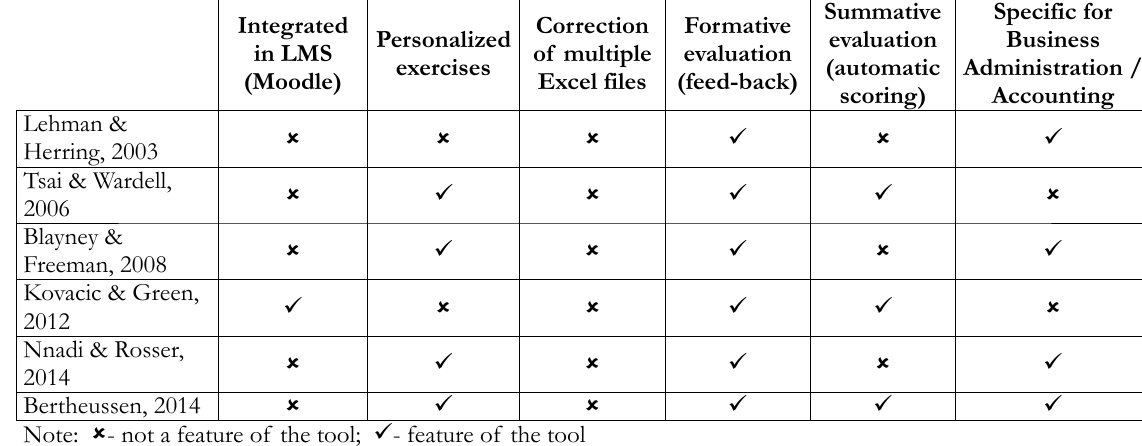
Table 1 . Characteristics of automatic spreadsheet correctors, a literature review